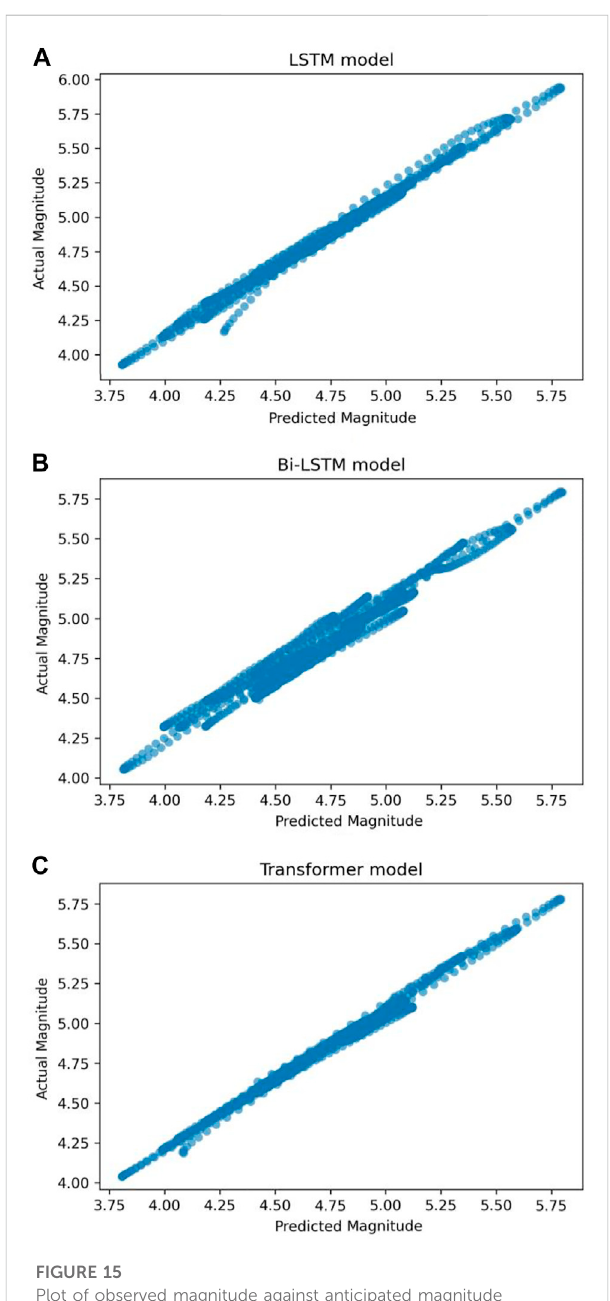
FIGURE 14 Plot of projected and actual magnitude as a function of time for the Japan earthquake catalogue using the (A) LSTM, (B) Bi-LSTM, and (C) transformer models.